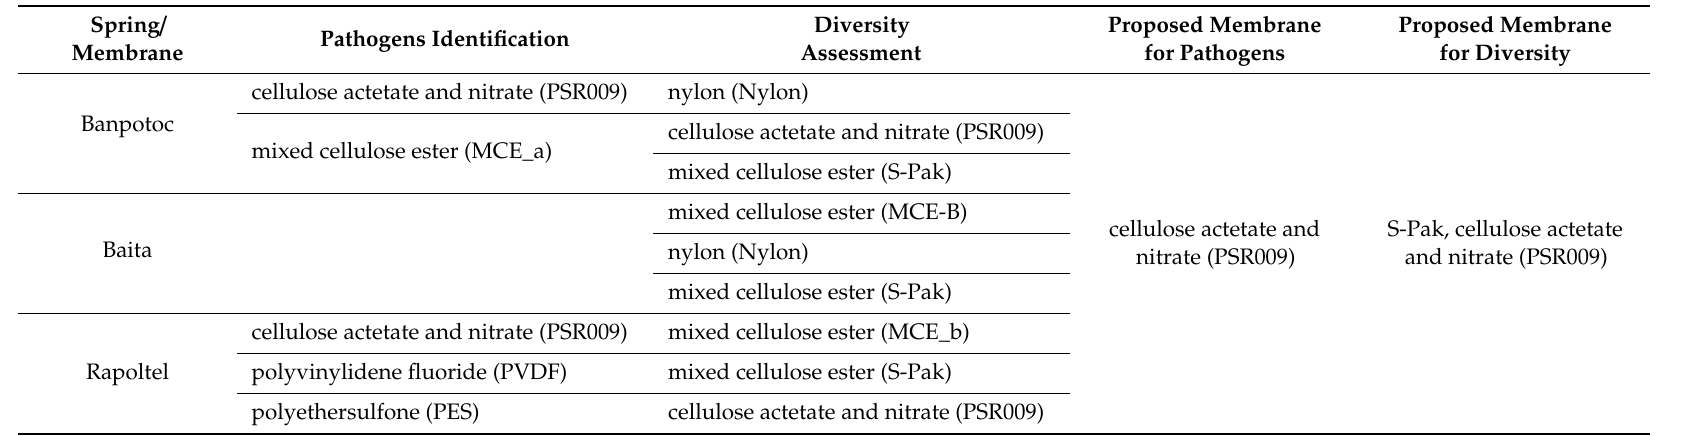
Table 5. The comparative analysis of the di ff erent membranes for 16S metabarcoding of karstic springs for diversity and quality analysis. The selected membranes have a porosity of 0.2–0.22 µ